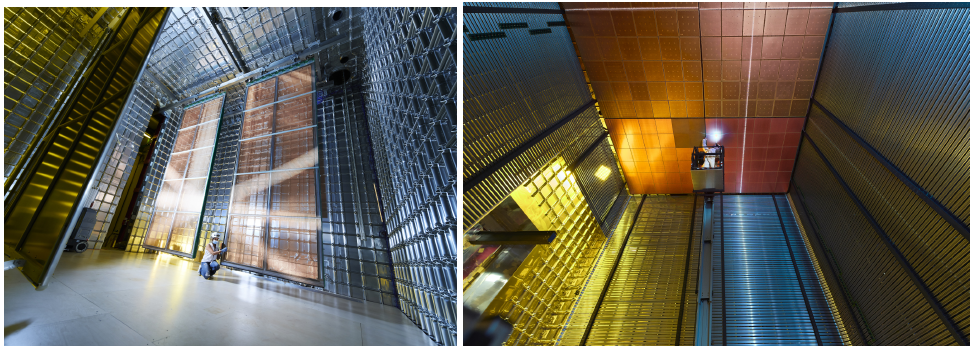
Figure 13. ( Left ): Inner view of ProtoDUNE-SP. ( Right ): Drift volume of ProtoDUNE-DP. Image: CERN.